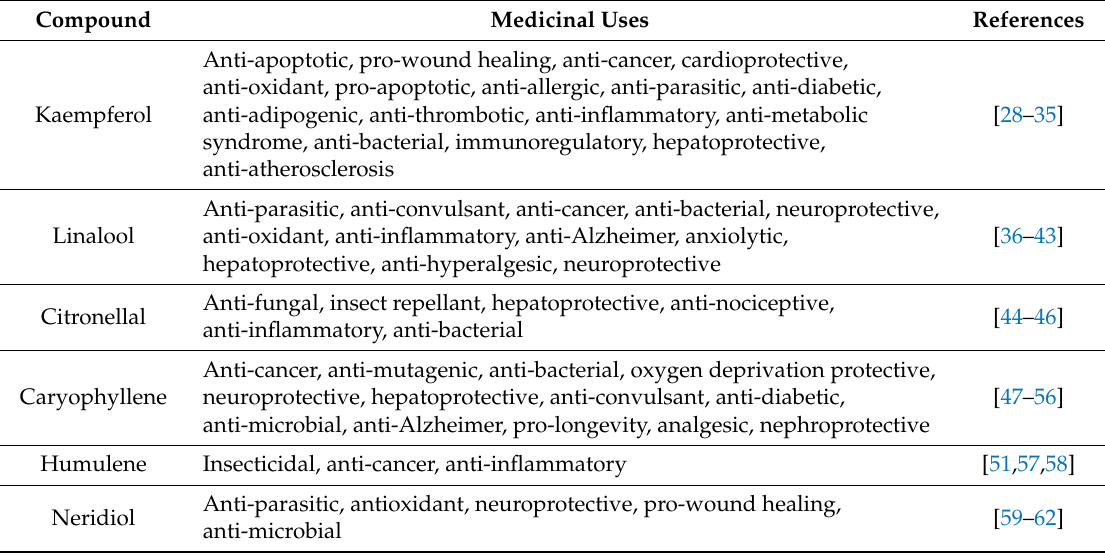
Table 1. Medicinal properties of phytochemicals present in Lilium candidum . Compound Medicinal